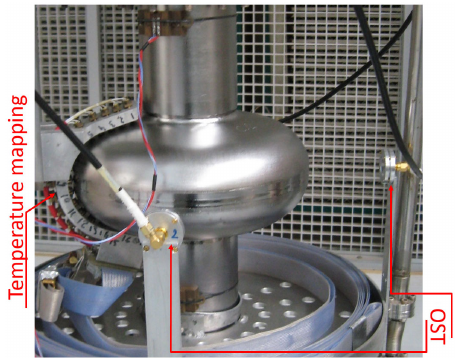
FIG. 1. 1.3 GHz single-cell cavity equipped with temperature mapping system and